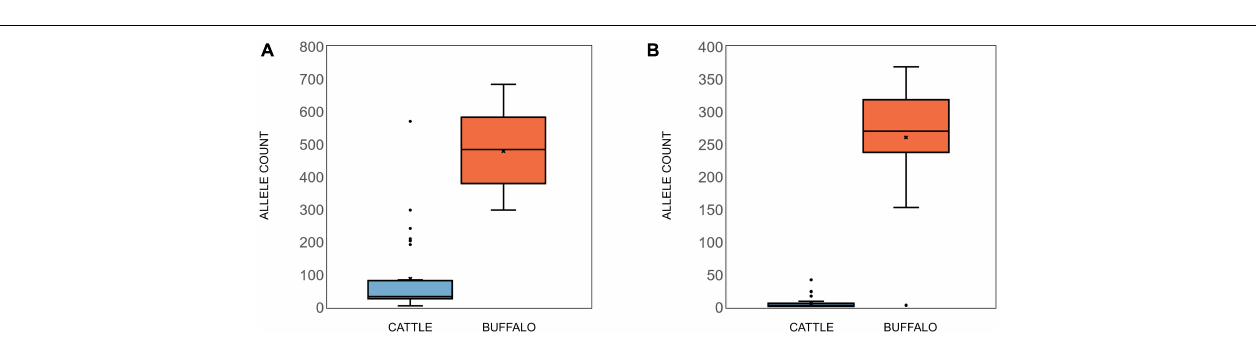
FIGURE 6 | (A) Single Nucleotide Polymorphism (SNP), insertion and deletion (INS/DEL) frequencies across the amplicon length of Tp4, with respect to the TpM reference sequence, highlighting increased mutation rates in intronic regions. SNPs are represented in black, insertions in green, and deletions in red. The outermost histogram represents buffalo, the middle represents cattle and the inner represents TpM. Intronic regions are highlighted in gray. (B) SNP/INDEL frequency for amplicon data across the length of the Tp4 amplicon, with respect to the TpM reference sequence. The mean calculated SNP/INDEL frequency is shown at each base location for the Tp4 gene. Blue bars represent SNPs, black bars represent insertions and red bars represent deletions. (C) SNP/INDEL frequency across the length of the Tp16 amplicon, with respect to the TpM reference sequence. The mean calculated SNP/INDEL frequency is shown at each base location for the Tp16 gene. Blue bars represent SNPs, black bars represent insertions and red bars represent deletions.